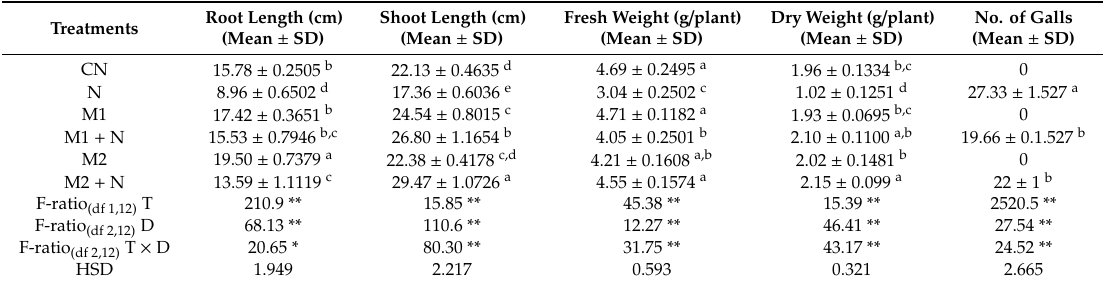
Table 1. Effect of M1 (10 9 cells / mL) and M2 (10 9 cells / mL) on: a root length, b shoot length, c fresh weight, nematodes (PPN)